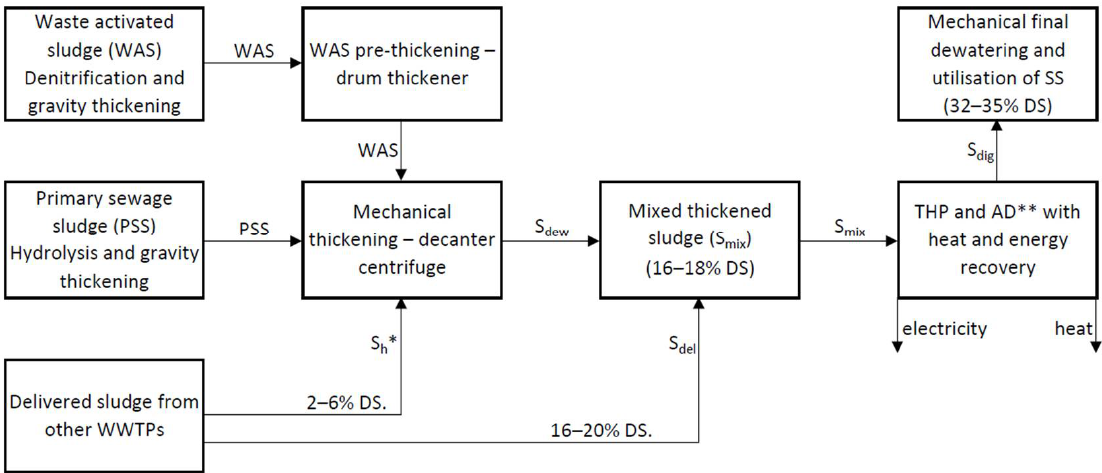
Figure 1. Technological process of sewage sludge (SS) treatment in Tarnów wastewater treatment plant (WWTP) [11]. * Delivered hydrated sludge (S h ) with 2–6% DS is dewatered and included in the mass of dewatered sludge (S dew ). ** Biogas is produced in the digestion process. S dew from the Tarnów WWTP, as well as S del , are directed to THP and AD. The sludge is dewatered in a decanter centrifuge manufactured by the Andritz Guinard model D5L using Praestol857 BC polyelectrolyte. All sludge subjected to the THP process is placed in a common silo and directed to the proper technological process as mixed sludge (S mix ).